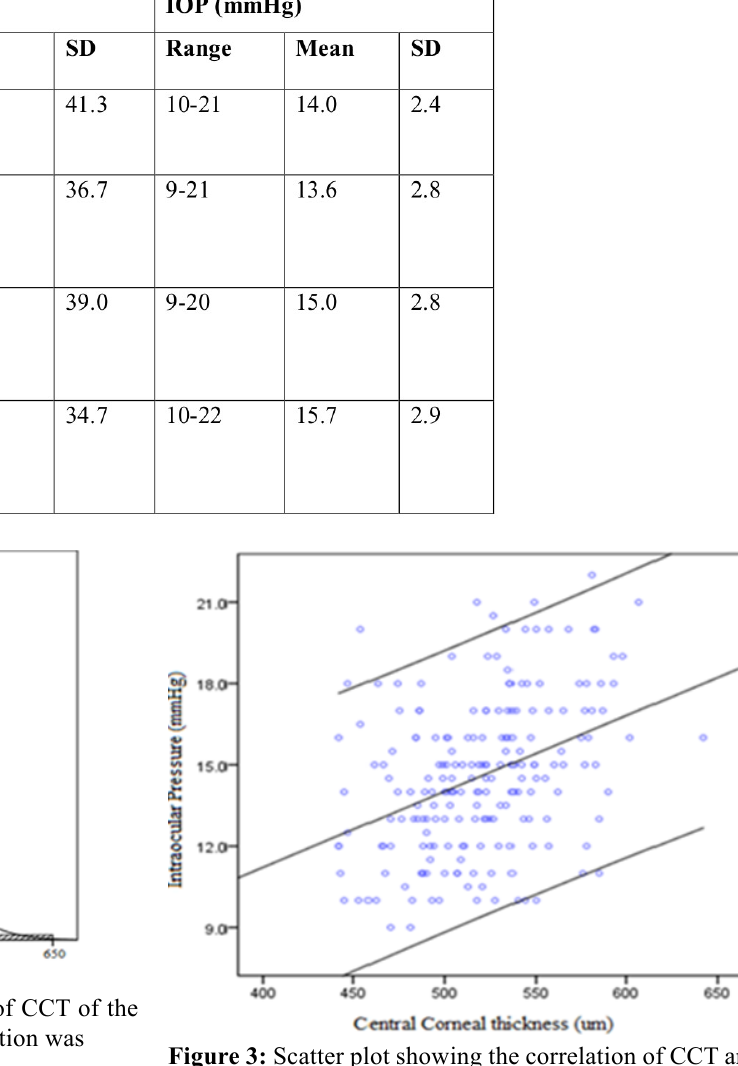
Figure 3: Scatter plot showing the correlation of CCT and IOP of in all the participants with 95% confidence interval of the regression line. ( R 2 = 0.146, r = 0.382, p < 0.001). The regres- sion line shows IOP = 0.028 CCT + 0.019.